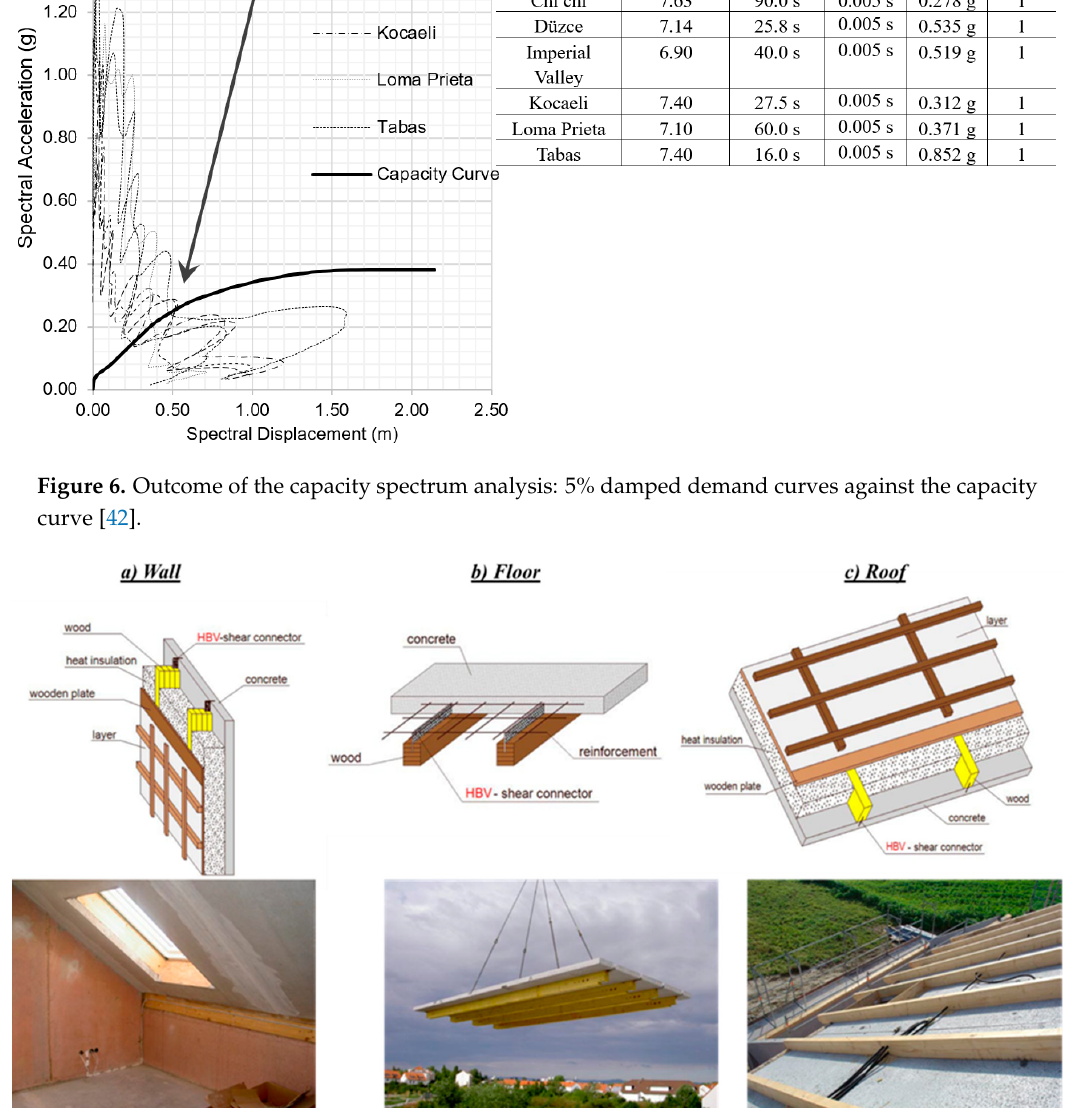
Figure 7. Elements of wood-concrete-composite buildings [63]: a ) Wall; b ) Floor; c ) Roof.